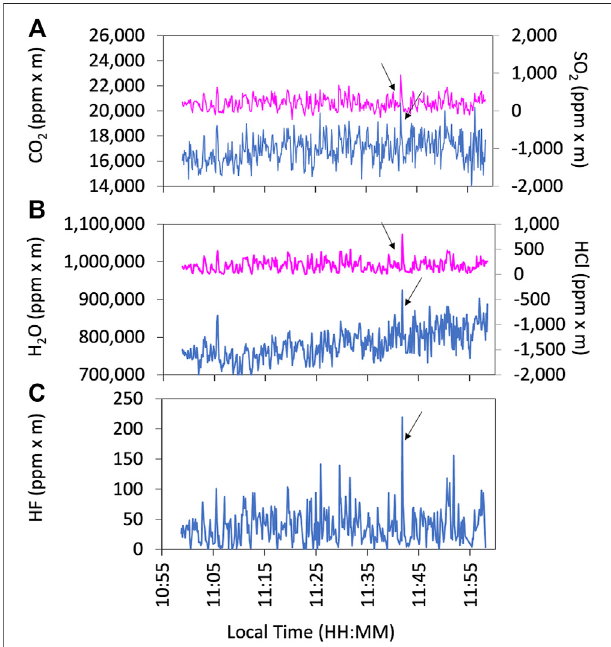
FIGURE 5 | Example of the FTIR observation results on 13 January 2018. Time series of CO 2 (blue line) and SO 2 (pink line) (A) , H 2 O (blue line) and HCl (pink line) (B) , and HF (blue line) (C) in column amount (ppm x m). The arrows indicate the corresponding plume signals for the analyses. Because all species are measured based on IR, there are no variations in the response time.